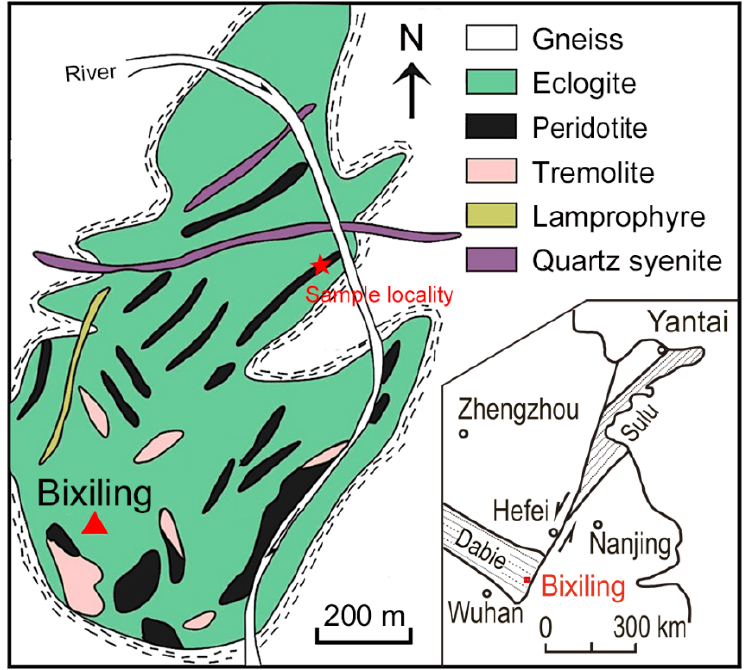
Figure 1. Geological map of the Bixiling complex, eastern Dabie orogenic belt, China. The meta-ultramafic rocks of the Bixiling complex are in gradational contact with the eclogite and exhibit greenish black layers as they are partially serpentinized. The studied peridotite sample is a medium grained (Figure 2), gray-black garnet peridotite consisting of serpentinized olivine (~65%), garnet (~15%), orthopyroxene (~10%), clinopyroxene